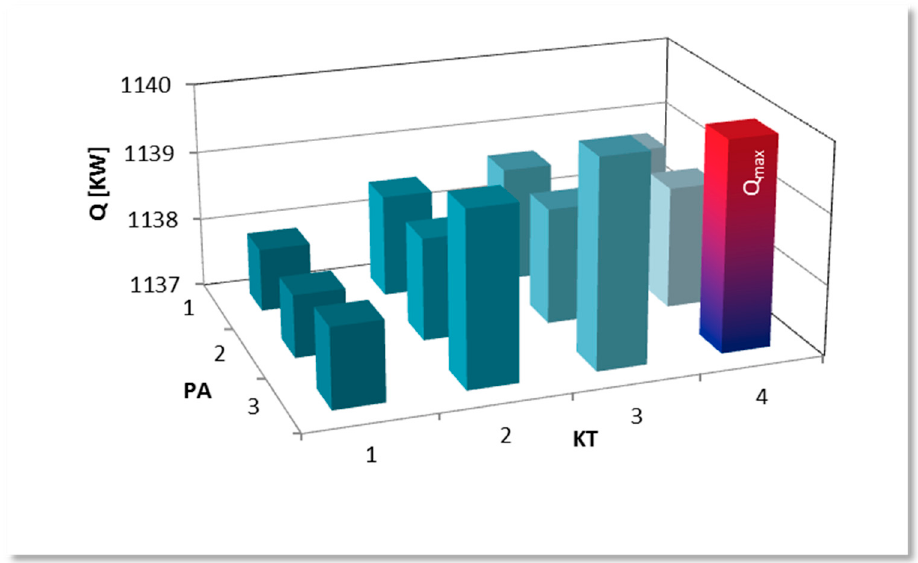
Figure 11. Effect of PA and KT on the total heat transfer rate of the evaporator, (n = 0.8, m = 8 kg/s).